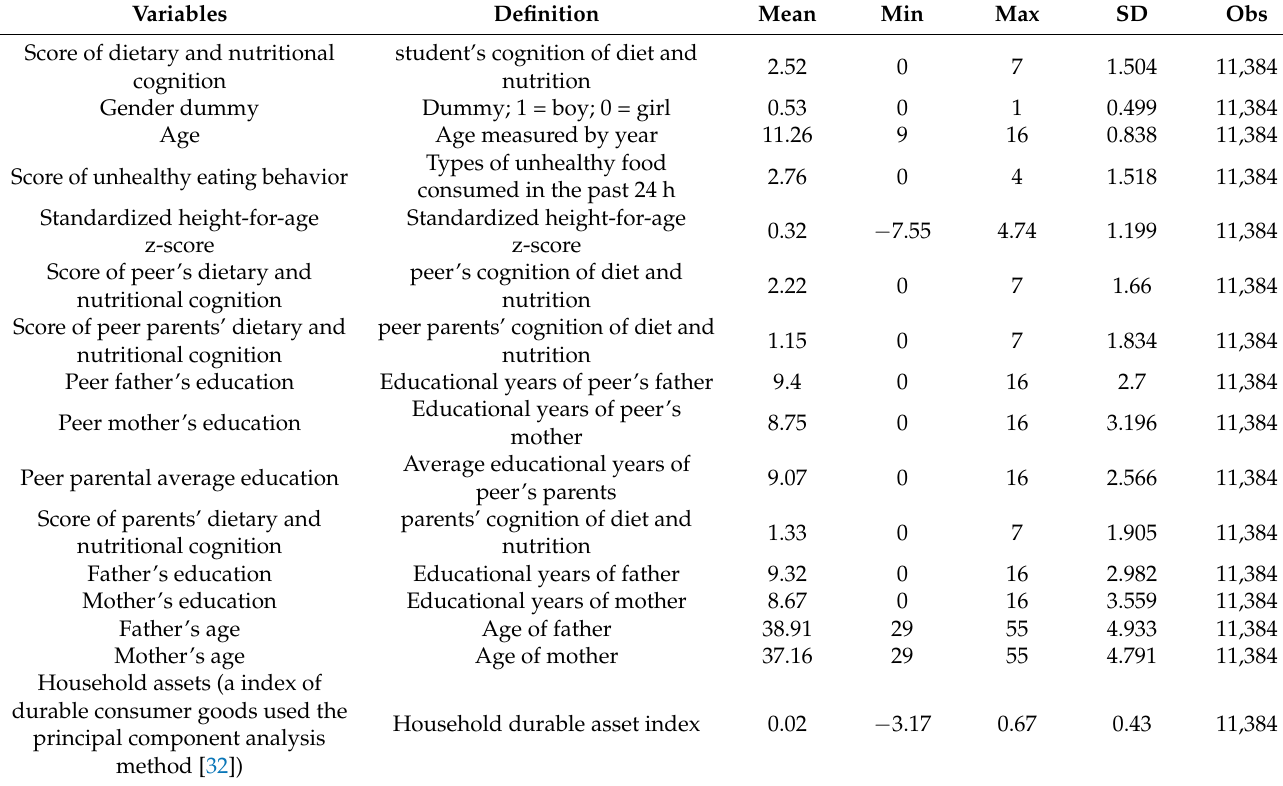
Table 1. Variables, variable names and summary